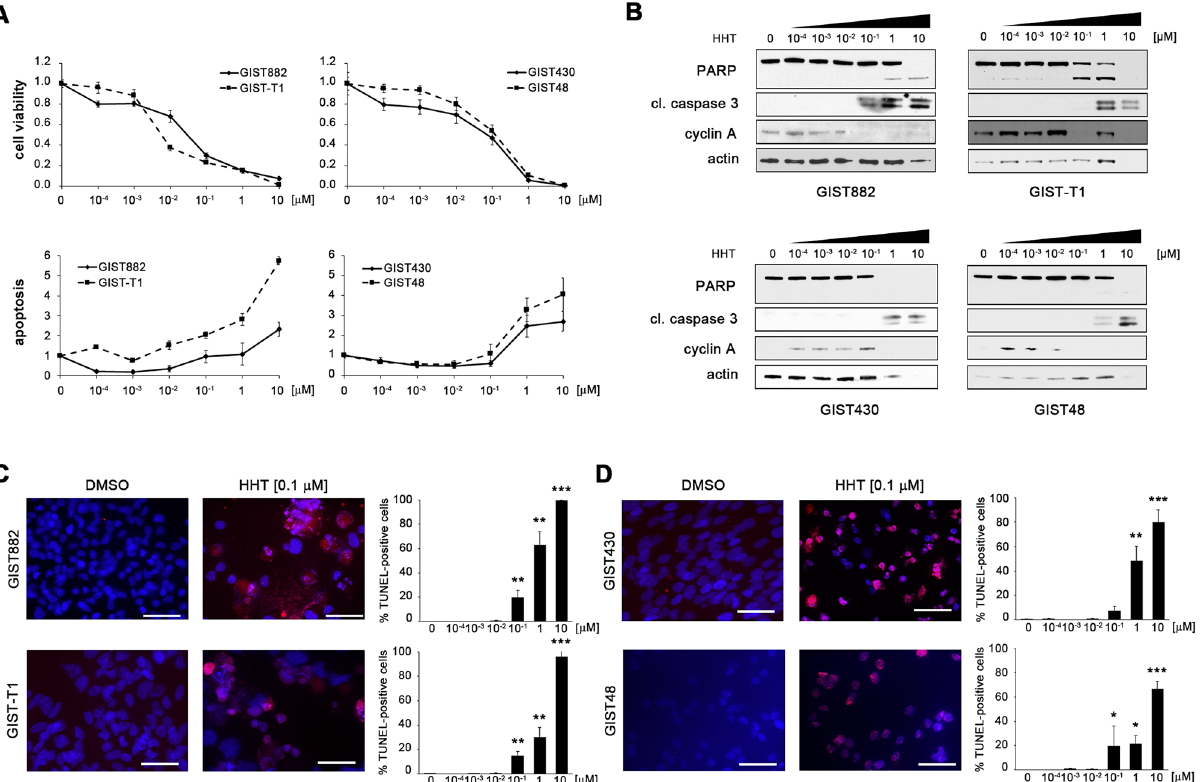
Figure 2. HHT has a pro-apoptotic effect in GIST cells and reduces cell viability in a dose-dependent manner. (A) Dose-dependent effect of HHT on cell viability (upper panels) and induction of apoptosis (lower panels) of IM-sensitive (GIST882, GIST-T1; left panels) and IM-resistant (GIST48, GIST430; right panels) GIST cells as measured by luminescence-based assays (mean +/− SE). (B) Immunoblot analysis for markers of apoptosis and cell cycle regulation after treatment of GIST cells with increasing concentrations of HHT (72 h) as indicated. Grouped immunoblot images are either cropped from different parts of the same gel or from a separate gel run with another aliquot of the same protein lysate. (C,D) Dose-dependent effect of HHT on induction of apoptosis in IM-sensitive (C) and IM-resistant (D) GIST cells as measured by TUNEL assay. Cells were treated for 72 h. Graphs represent mean and standard error of at least two experiments with an average of 500 cells counted per condition. Scale bar, 50 μm. Columns, mean + SE; *, p < 0.05 in comparison to DMSO control; **, p < 0.01 in